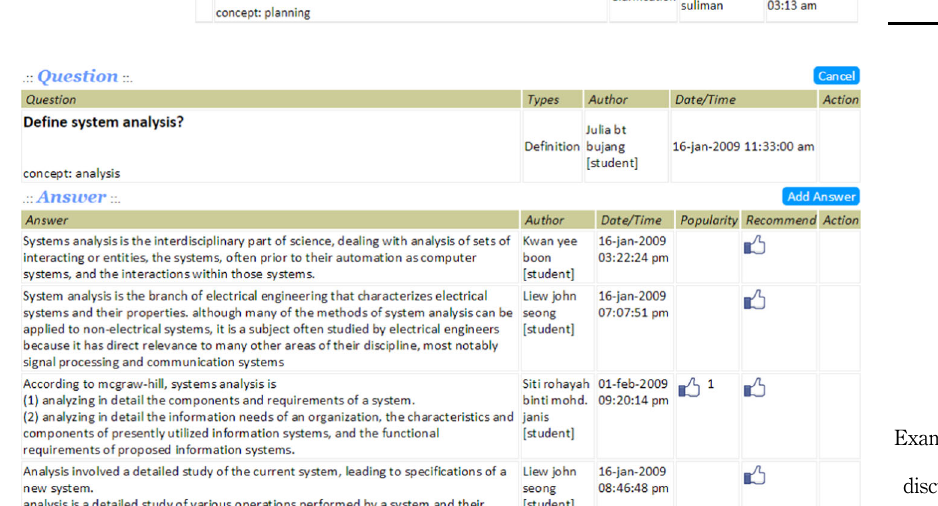
Figure 8. Example of discussion questions list interface